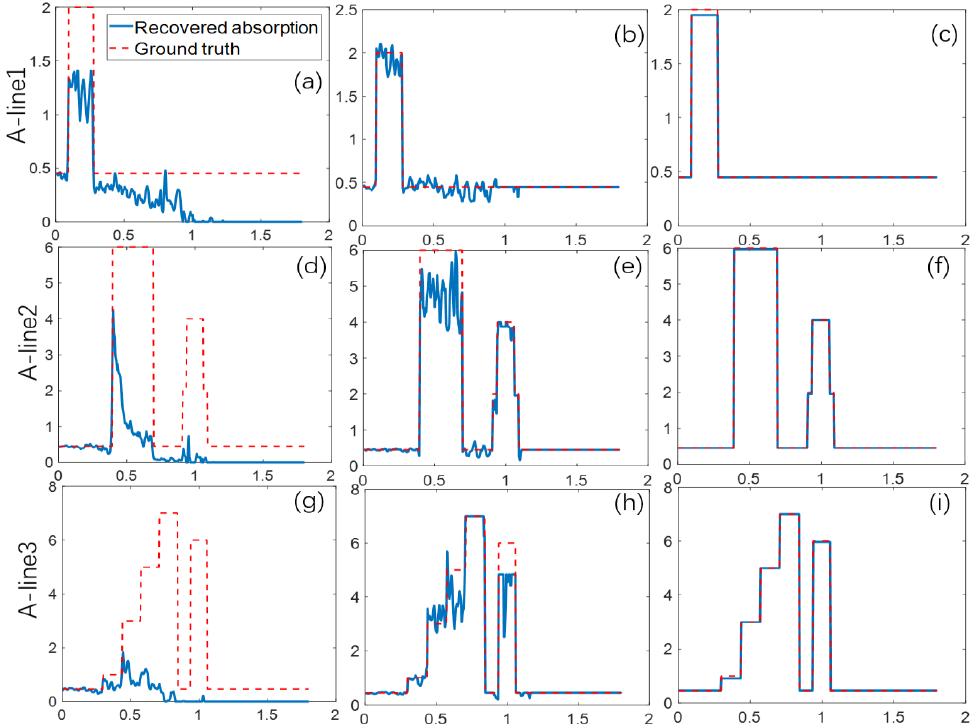
Figure 5. Three A-line profiles were selected to visualize the performance of the proposed quantitative recovery absorption coefficient method, which were the results of three iterations of 1, 5 and 10, respectively corresponding to the absorption distribution in Figure 4. Each row represents the same A-line, each column represents the result of the same iteration. The dotted red line represents the ground truth of absorption coefficient, the solid blue line represents the recovery of the absorption coefficient: ( a , d , g ) are No.1 iteration results; ( b , e , h ) are No.5 iteration results; ( c , f , i ) are No.10 iteration results with normalized. The x-coordinate axis (bottom) illustrate the spatial scale, the unit is cm, the ordinate (left) represents the value of the absorption coefficient, the unit is cm −1 .